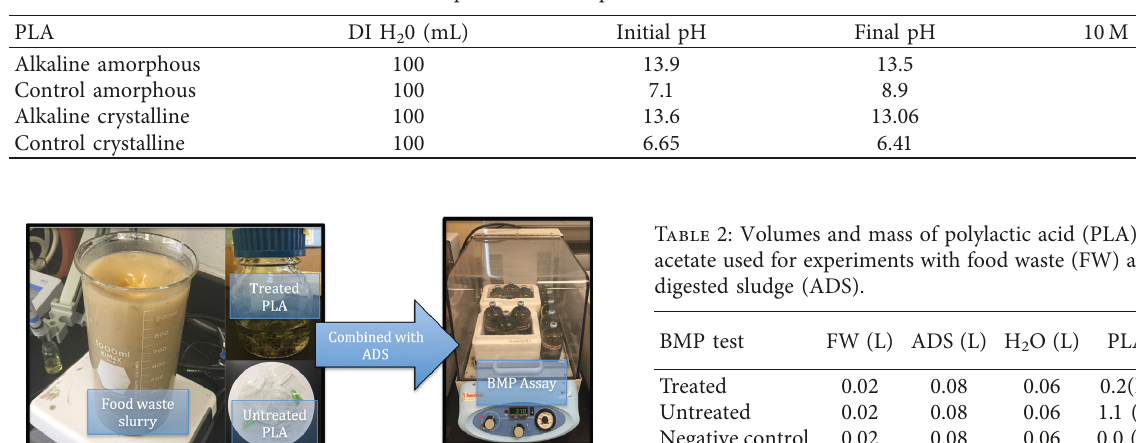
Table 1: Experimental composition of each solubilization test.